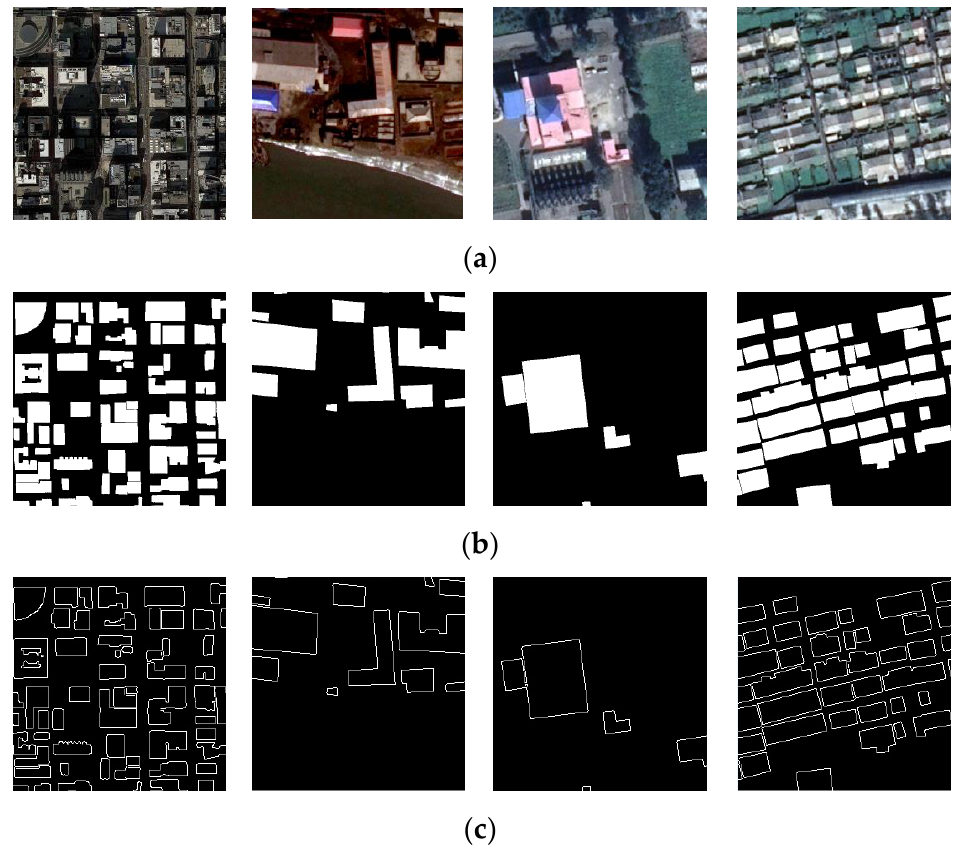
Figure 7. Example of subject edge feature training sample for MUM-Net: ( a ) Original HRRS images from WHU building dataset, ( b ) corresponding label images from WHU building dataset, ( c ) label images for MUM-Net.